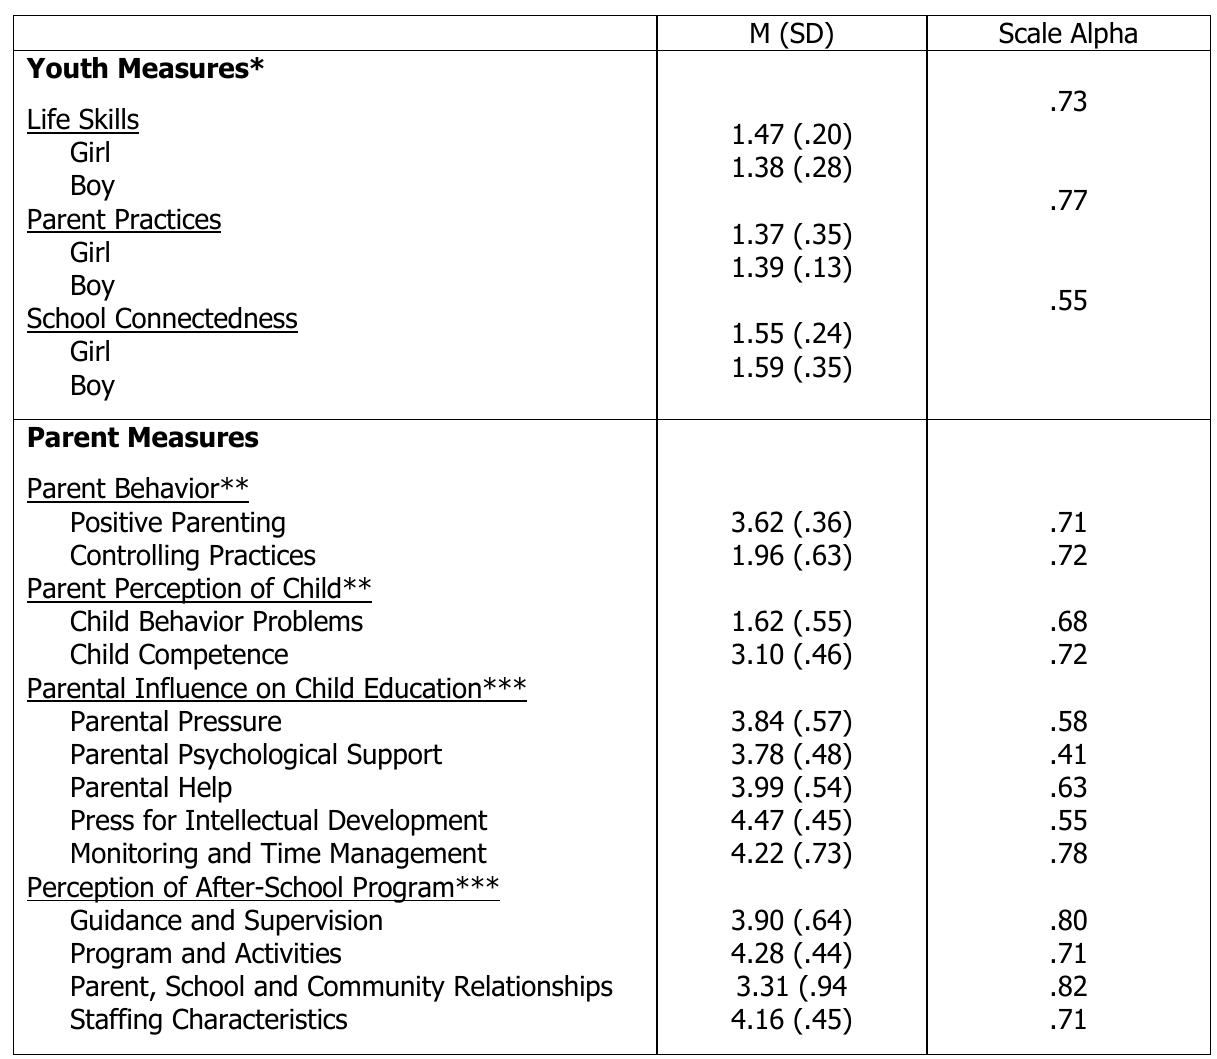
Mean Ratings of Youth and Parent Measures